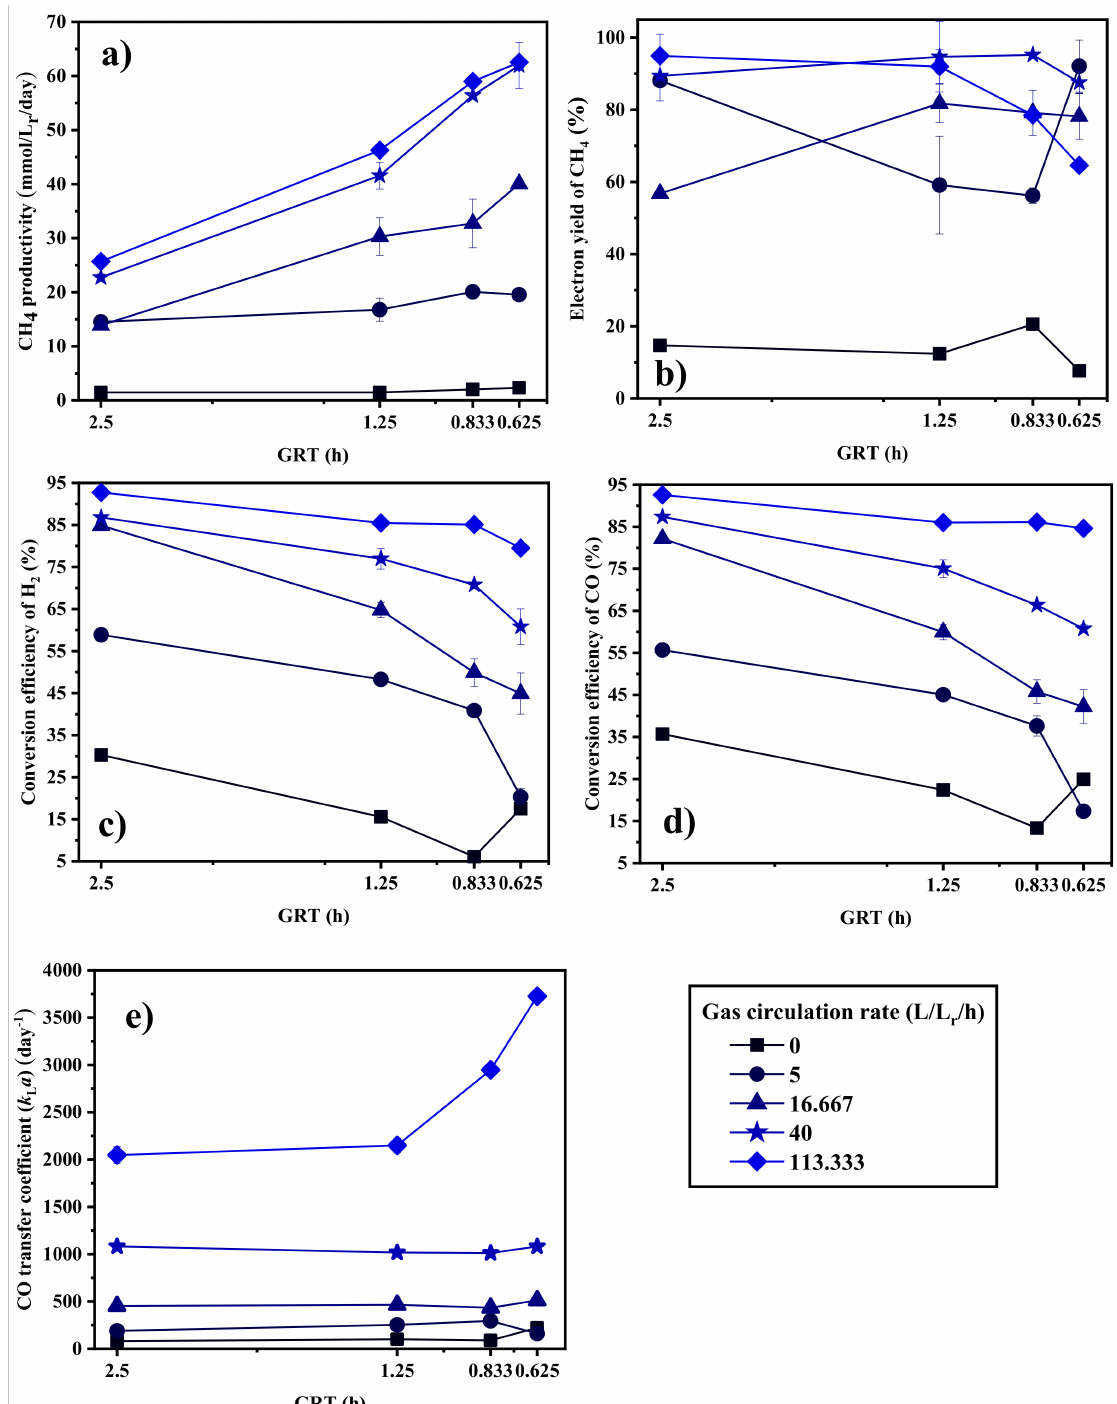
Figure 7. ( a ) CH 4 productivity, ( b ) electron yield to CH 4 , conversion efficiency of ( c ) H 2 and ( d ) CO, and ( e ) CO transfer coefficient ( k L a ) of the BCR-C at different